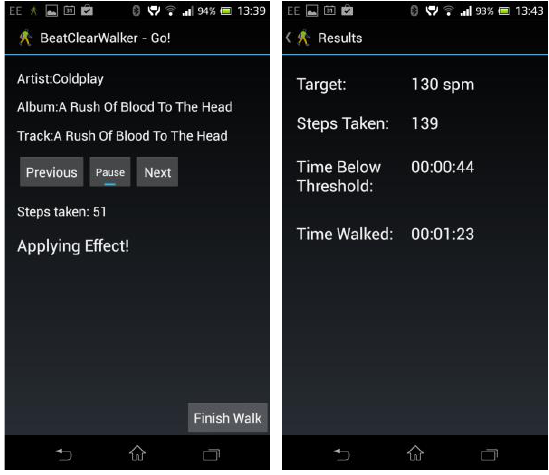
Figure 4: BeatClearWalker (left: while walking, right: report